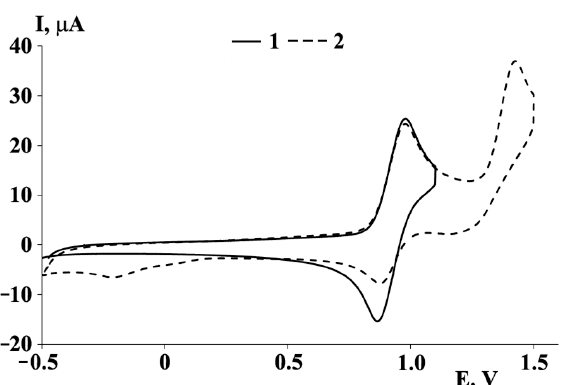
Figure 5. Cyclic voltammograms of 3 : the potential switch from − 0.50 to 1.10 V (curve 1); the potential switch from − 0.5 to 1.5 V (curve 2) (CH 2 Cl 2 , C = 2 mmol, 0.1 M TBAP, scan rate 200 mV · s − 1 ).